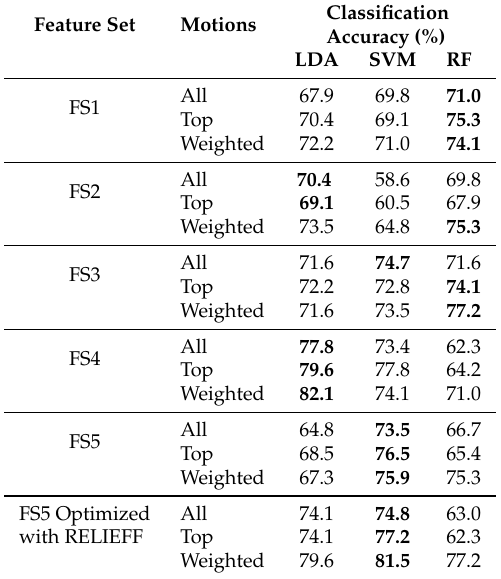
Table 6. Majority vote classification accuracies. Majority vote decisions were developed from all ten motions, from only the top motions (EF, EE, P, S, WF, UD, and HC), and from a weighted majority vote. The best classification results within each feature set are in